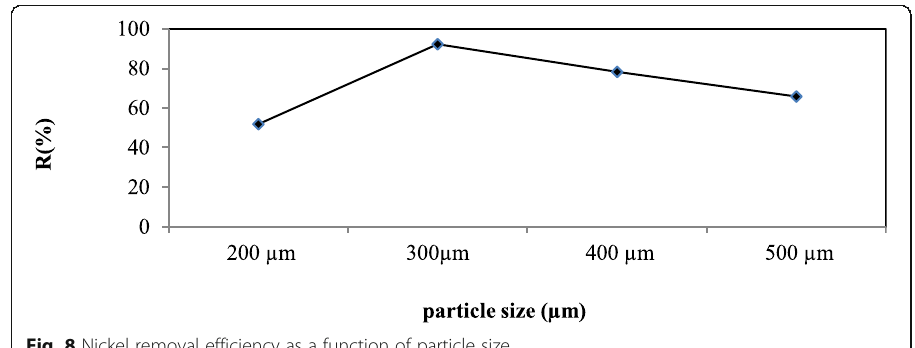
Fig. 8 Nickel removal efficiency as a function of particle size